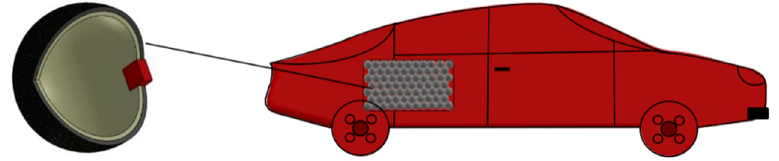
Figure 2. New H 2 storage system in a common